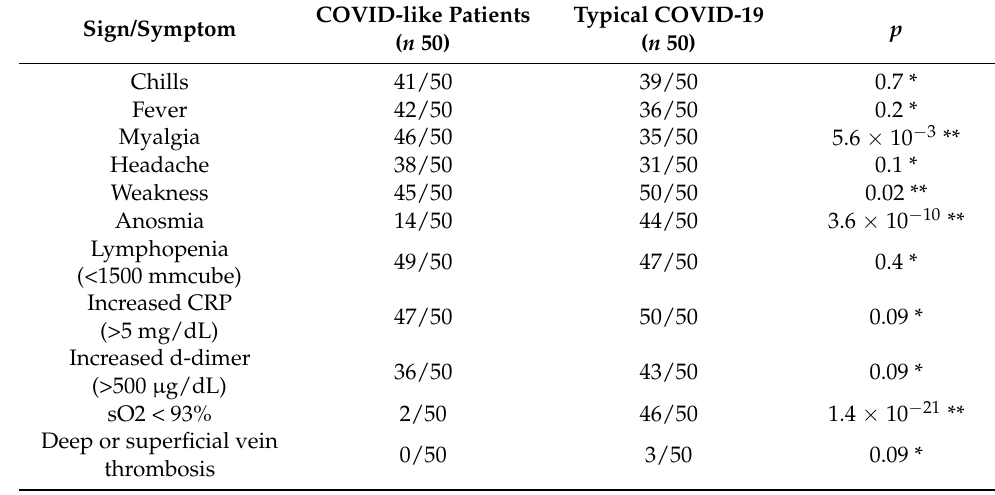
Table 1. Clinical characteristics of patients with COVID-like syndrome and typical COVID-19.